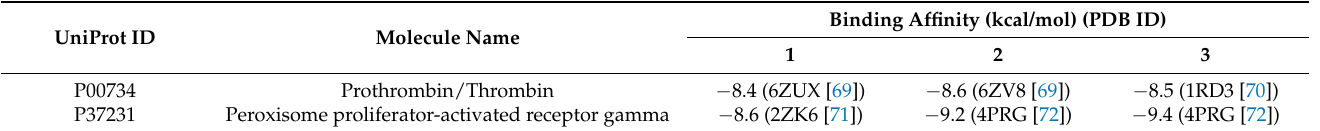
Table 4. The most retrieved targets shared between 1 , 2 , and 3 and the corresponding best bind- ing